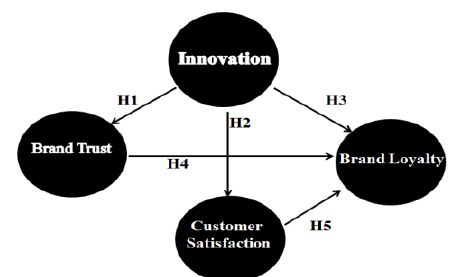
Figure 1. The Model of the Impact of Innovation